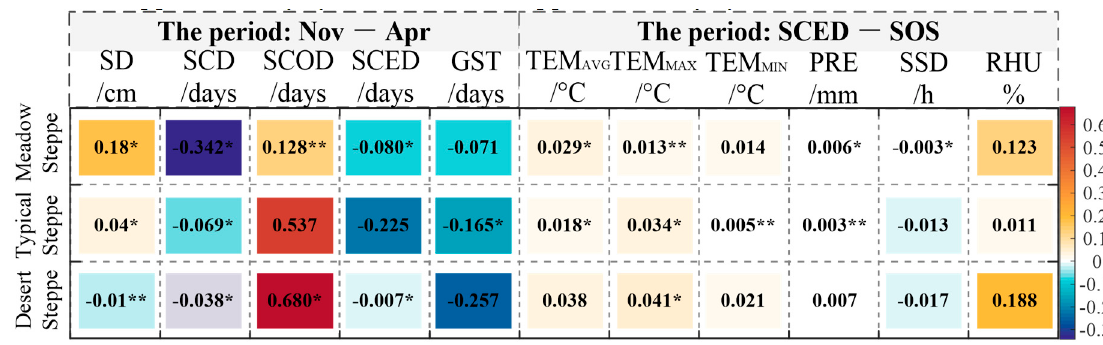
Figure 6. The interannual variability of each climate factor in different grassland types. The value in each grid indicates the rate of change for each climate factor. Values are also color-coded, with blue indicating negative values and red indicating positive values. The color of each grid corresponds to the value, with the color bar on the right of the table. The asterisks (*) indicate the climate factors trends that are statistically significant at the p < 0.1 level, and the double asterisks (**) indicate significance at the p < 0.05 level.